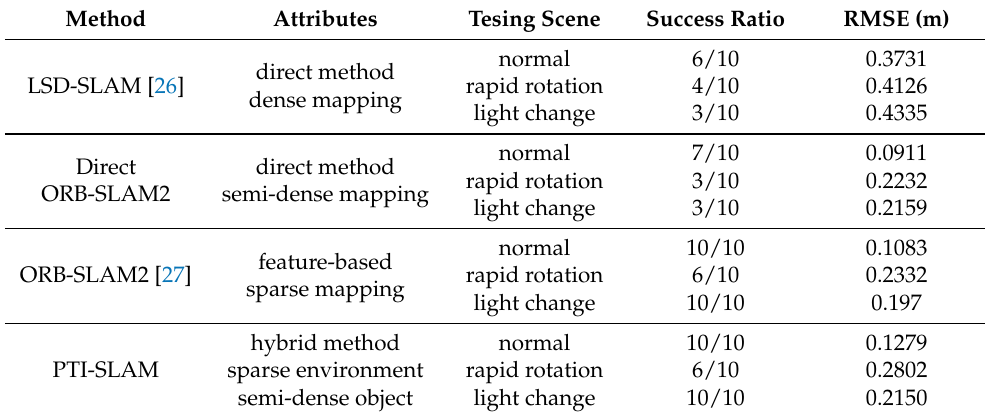
Table 7. Comparison on robustness of algorithms.